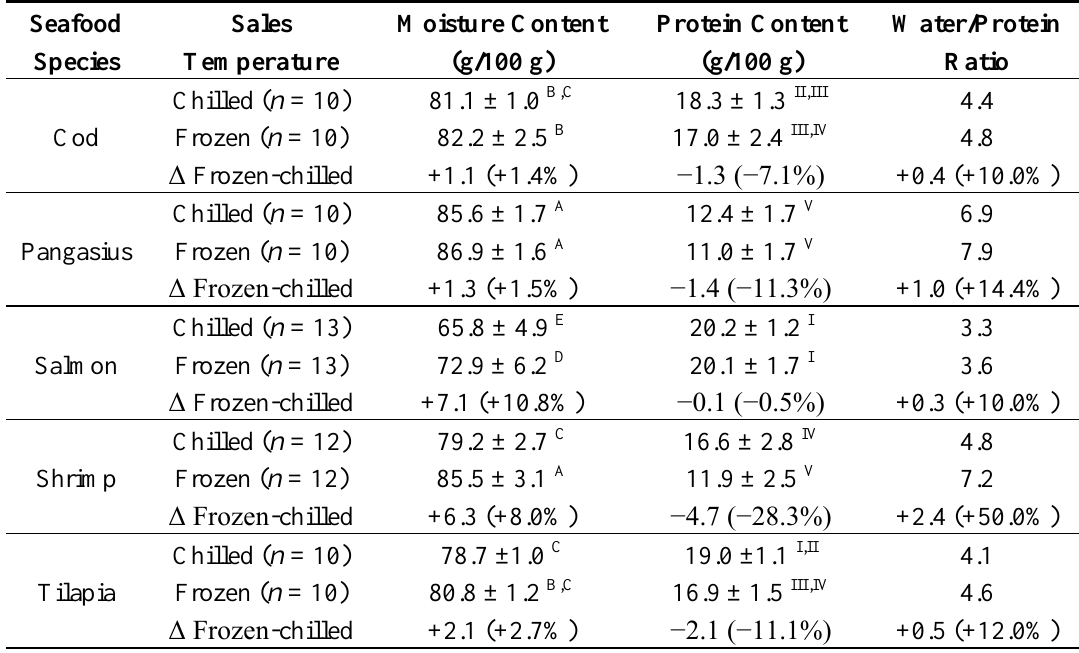
Table 3. Moisture contents, protein contents and water/protein ratios in various seafood samples (mean ± SD) 1